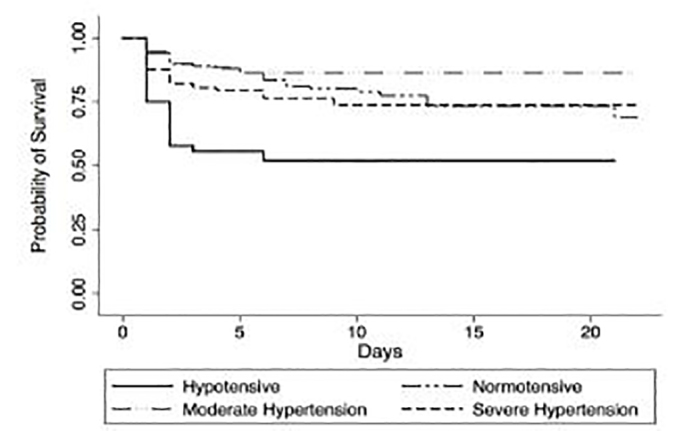
Kaplan Meier curve by blood pressure category.